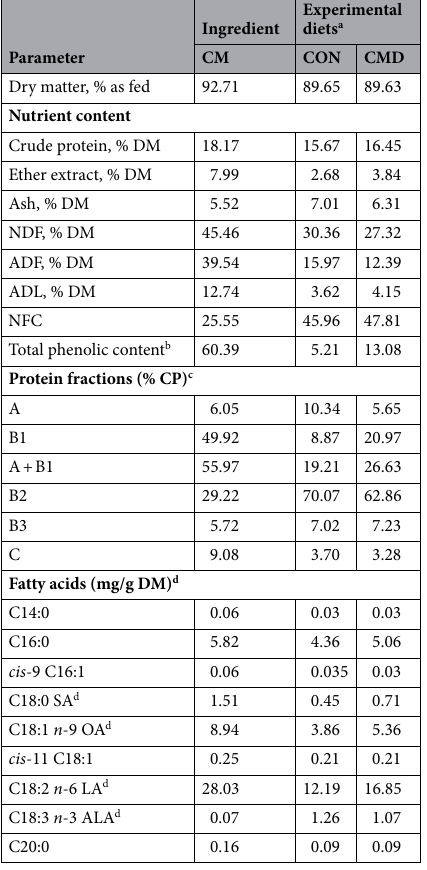
Table 1. Chemical composition of cardoon meal (CM) and experimental diets. NDF neutral detergent fiber, ADF acid detergent fiber; ADL acid detergent lignin, CP crude protein, NFC non-fiber carbohydrates = 100 – ((NDF—NDFIP) + crude protein + ether extract + ash), where NDFIP represents the protein fraction linked to NDF. a CON control diet; CMD cardoon meal diet. b Expressed as grams gallic acid equivalents/kg DM. c A: non- protein nitrogen; B1: true protein soluble in buffer; A + B1: total soluble nitrogen; B2: neutral detergent soluble protein; B3: neutral detergent insoluble protein but soluble in acid detergent; C: acid detergent insoluble protein. d SA: stearic acid, OA oleic acid, LA linoleic acid, ALA α-linolenic